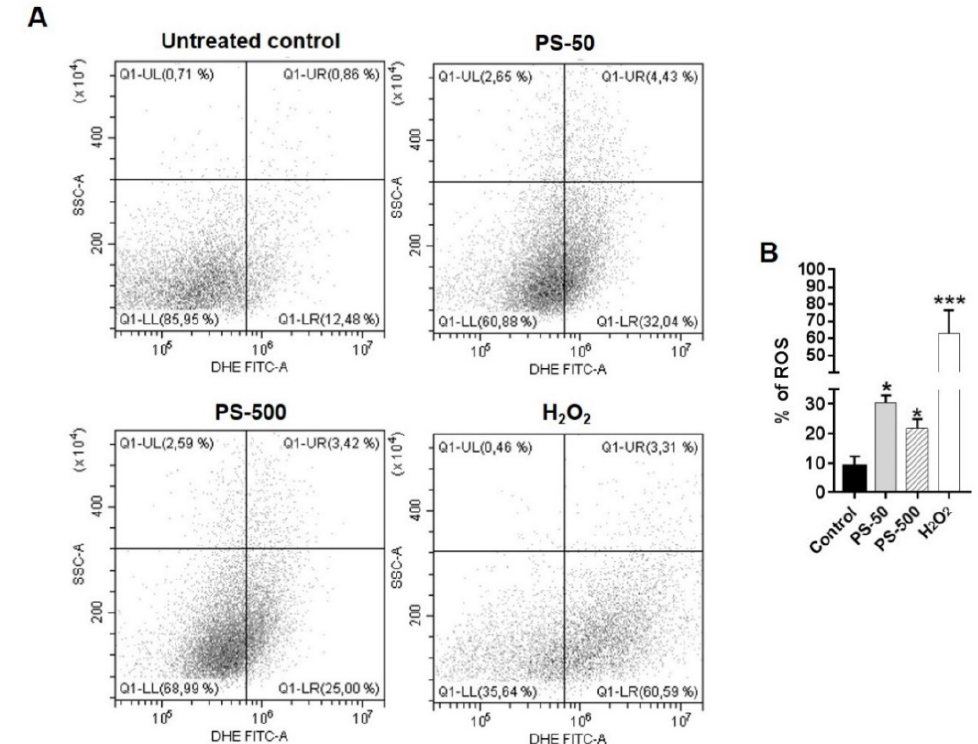
Figure 4. The dot plots and graph indicated the generation of intracellular reactive oxygen species (iROS) due to PSNPLs in HNEpCs after 24 h of treatment. ( A ) The dot plots represented the increased percentage of iROS in both PS-50- and PS-500-treated cells (far right quadrant) over the untreated control. H 2 O 2 acted as a positive control. ( B ) The graph represented the significant increase in the percentage of iROS due to PS-50 and PS-500 in the treated cells vs. untreated control cells. * p ≤ 0.05, *** p ≤ 0.001.